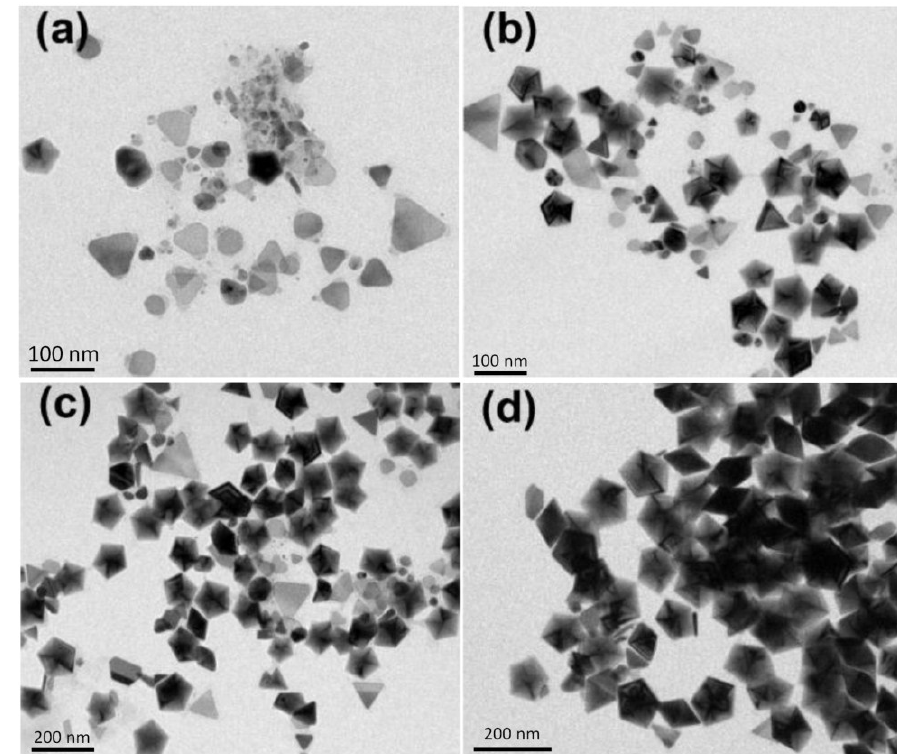
Figure 7. TEM images of the silver nanoparticles synthesized at 10 °C and at different reaction times: ( a ) 7 h; ( b ) 19 h; ( c ) 27 h and ( d ) 45